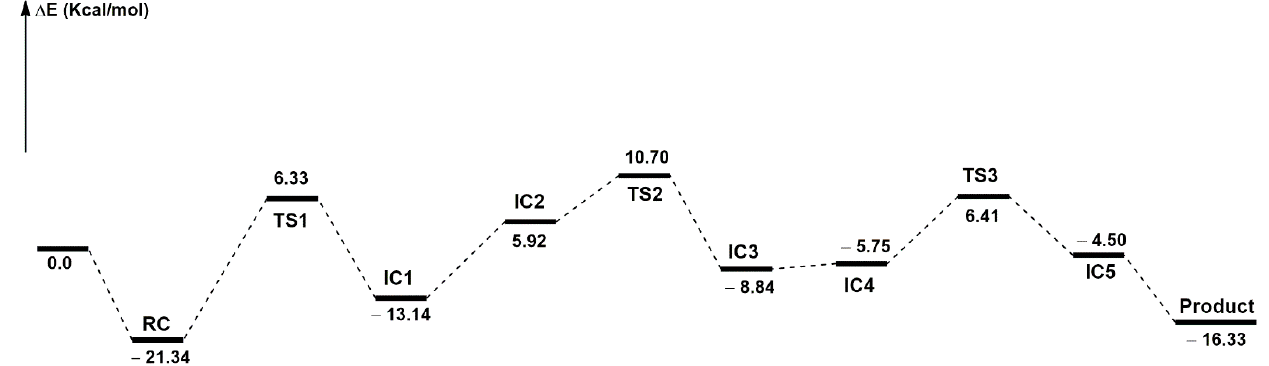
Figure 5. DFT-computed energy profile for the synthesis of 4a using SA as a catalyst in water. All values are reported in kcal/mol.